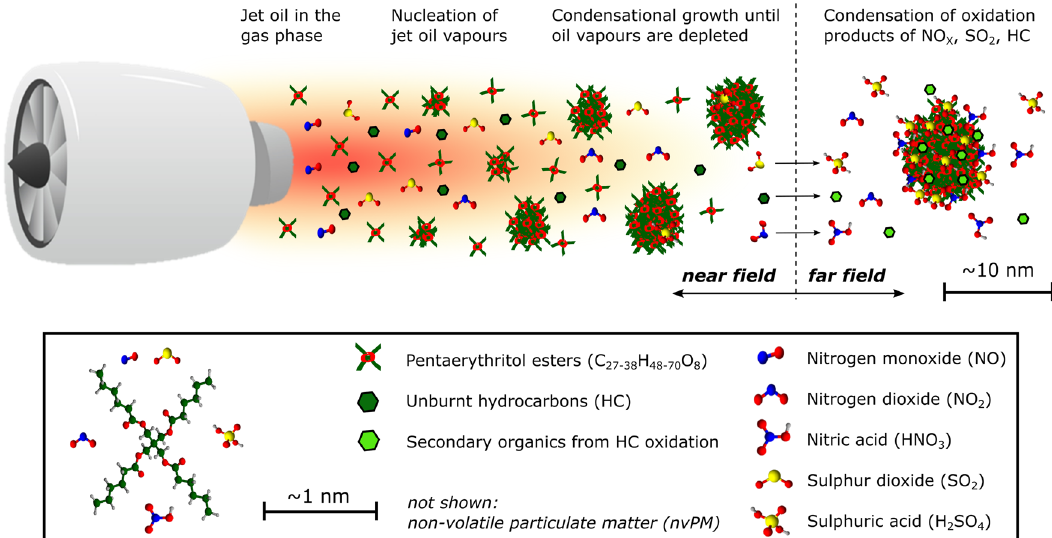
Fig. 4 Conceptual illustration of the UFP formation. Emissions of aircraft turbofan engines result in fast nucleation and growth of jet oil vapours in the near fi eld. Non-volatile emissions (nvPM) are not shown. Dimensions are not true to